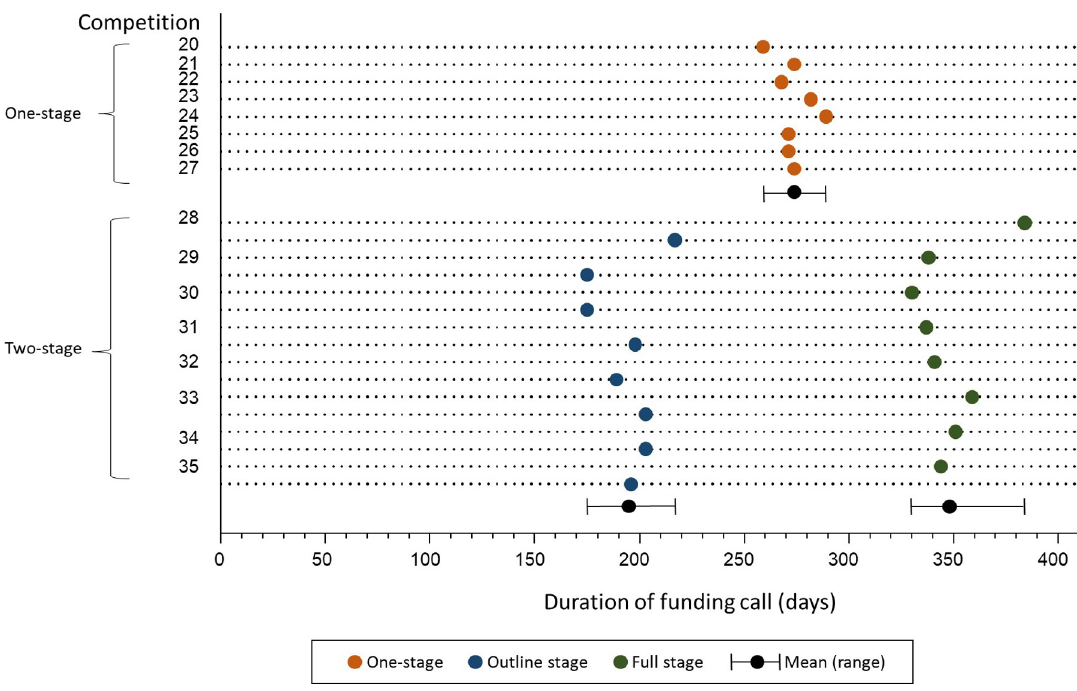
Fig 3. Funding round durations.